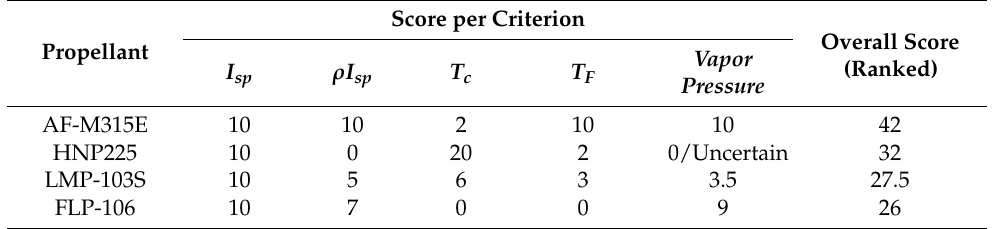
Table 8. Trade-off study results and propellants